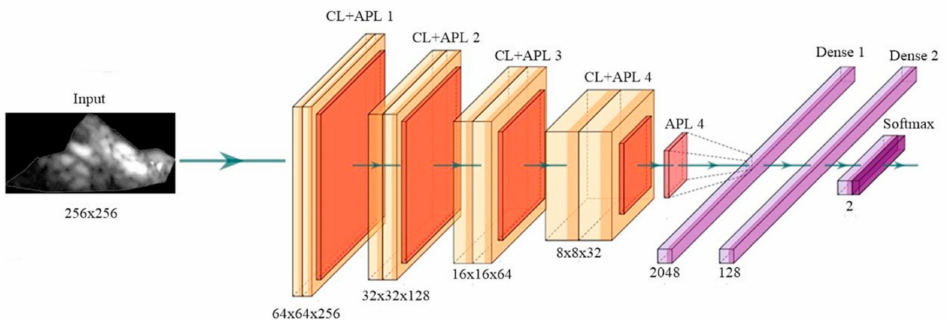
Figure A1. The general structure of CNN architecture (courtesy of AtheroPoint™, Roseville, CA, USA)